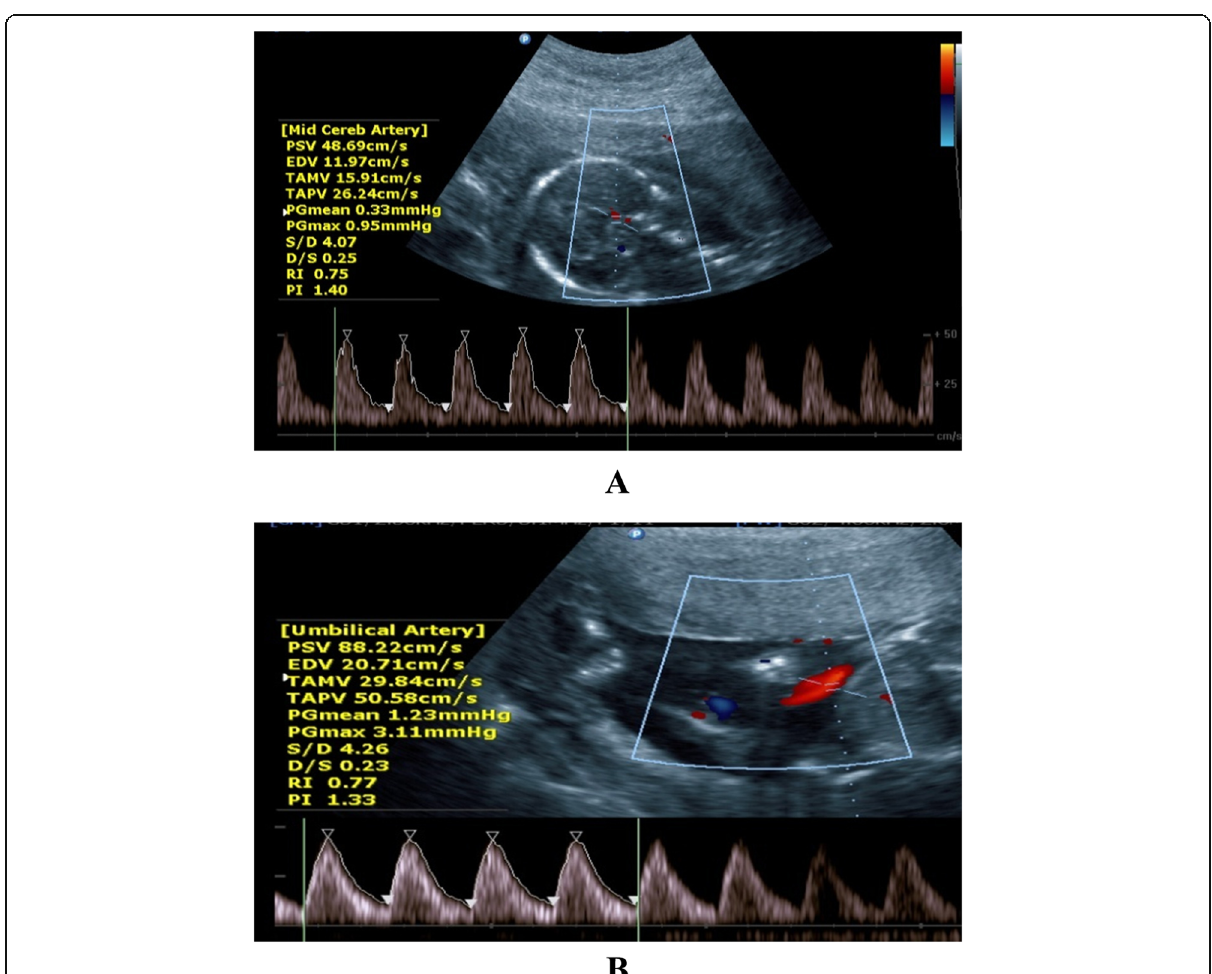
Fig. 5 Normal Doppler imaging of MCA and UA at 18 weeks of gestational age in a 31-year-old female mother. FHR, 151 b/m; placenta grade II; and EFW, 202 g. a Doppler US examination of fetal MCA revealed PSV = 48.69, S/D = 4.07, RI = 0.75, and PI = 1.40. b Doppler US examination of maternal UA revealed PSV = 88.22, S/D = 4.26, RI = 0.77, and PI = 1.33. CPR Doppler values: PSV = 0.55, S/D = 0.96, RI = 0.97, and PI =